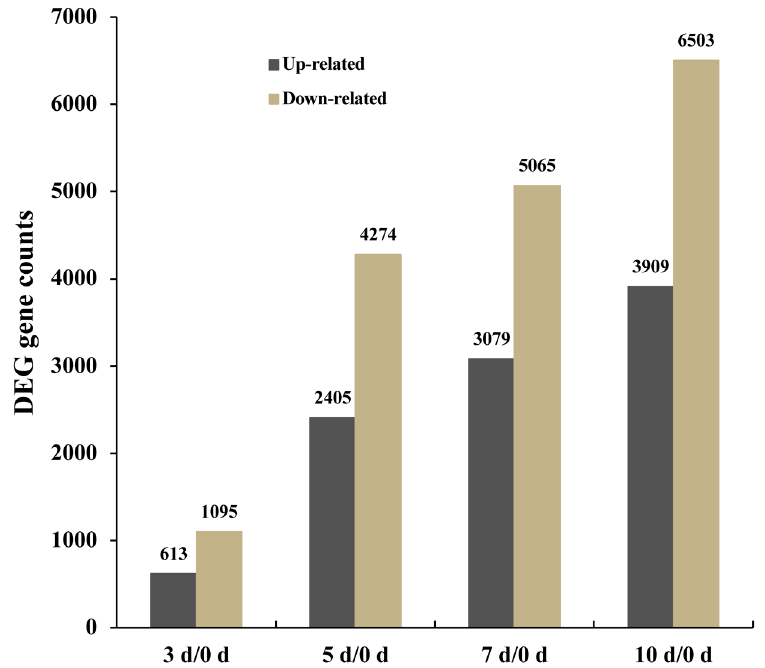
Figure 3. Number of differentially expressed genes in G. anomalum under drought stress. 0 d, 3 d, 5 d, 7 d, and 10 d refer to 0, 3, 5, and 10 days after drought stress.